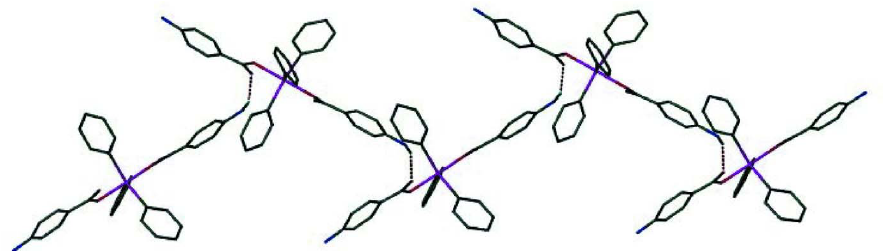
The molecular structure of the compound, showing 50% probability displacement ellipsoids. H atoms have been omitted for clarity.